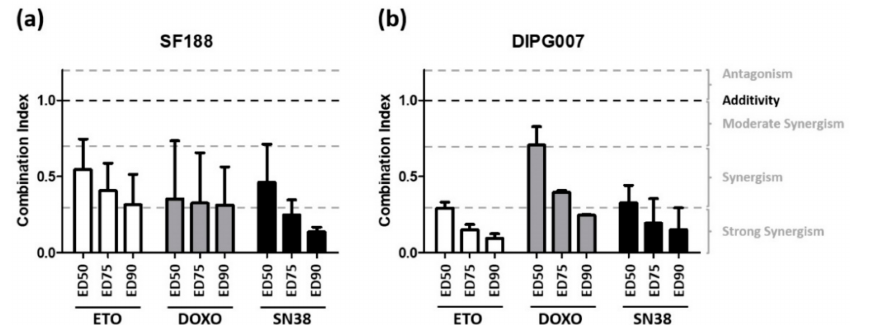
Figure 3. Determination of synergy between Evo and cytotoxic agents. The synergistic effect of Evo was evaluated in combination with etoposide (white), doxorubicin (grey), and SN38 (black) in SF188 ( a ) and DIPG cells ( b ). Cytotoxicity was determined after 72 h of drug exposure under 1% O 2 and the synergistic effect was analyzed by Chou and Talalay’s method. Histograms represent the mean of three independent experiments ± SD. Results are presented as combination index (CI) at ED50, ED75, and ED90. A combination was considered as synergistic if CI <